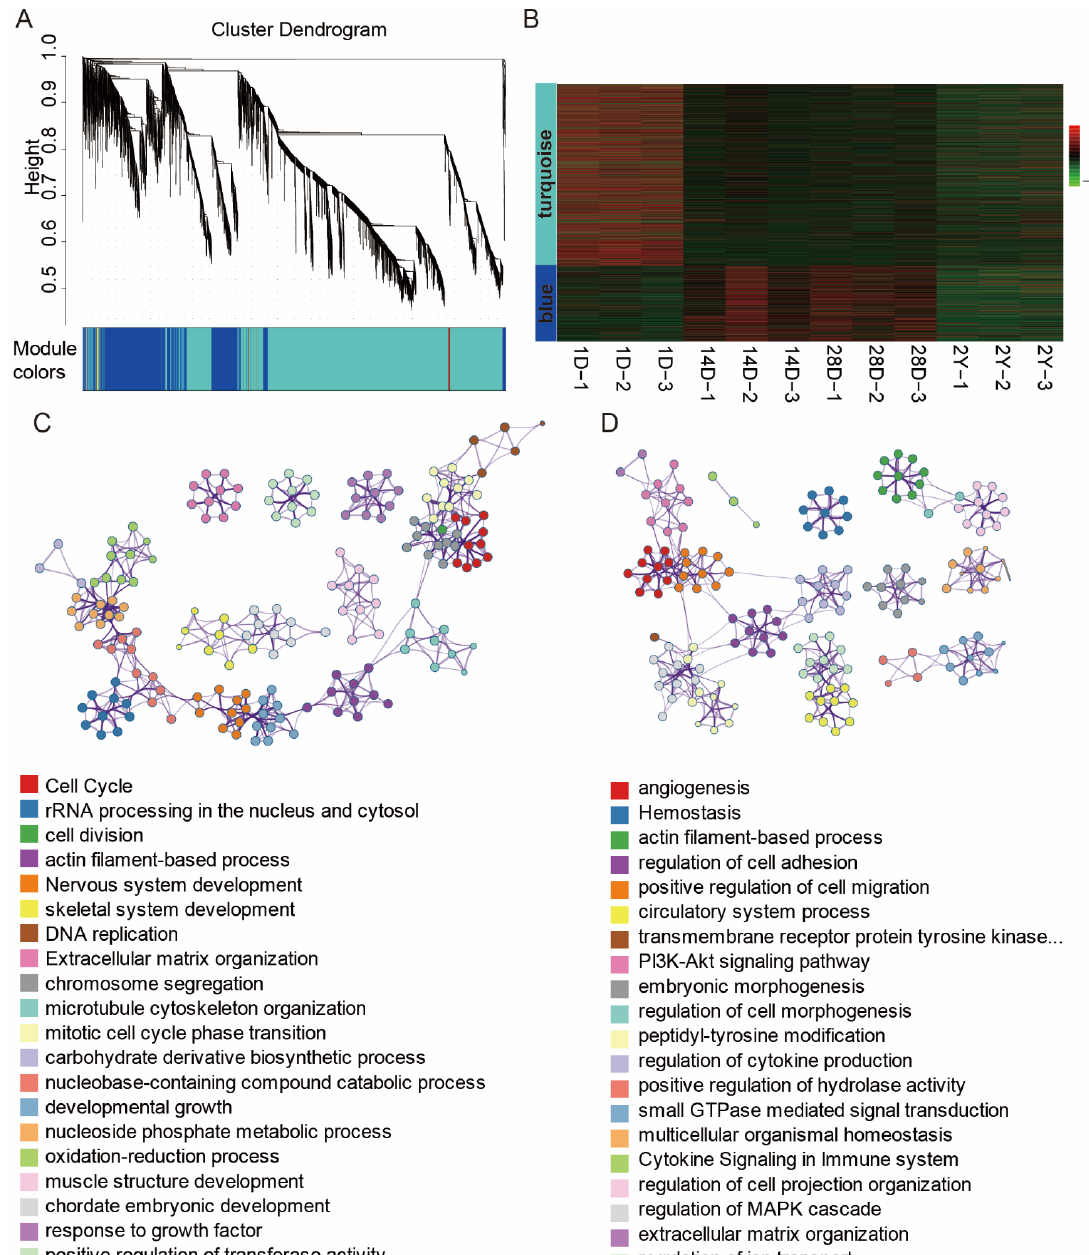
Figure 5. DE-lncRNA and DE-mRNA co-expression networks. ( A ) The co-expression network was constructed using the WGCNA method. The cluster dendrogram was produced using average linkage hierarchical clustering and is shown in the top panel. The bottom panel uses five colors to display the co-expression modules of lncRNAs and mRNAs. ( B ) Heat map showing the gene expression of the largest two co-expression network modules (blue and turquoise modules). ( C , D ) Functional categories of the mRNAs corresponding to turquoise and blue modules of lncRNAs.